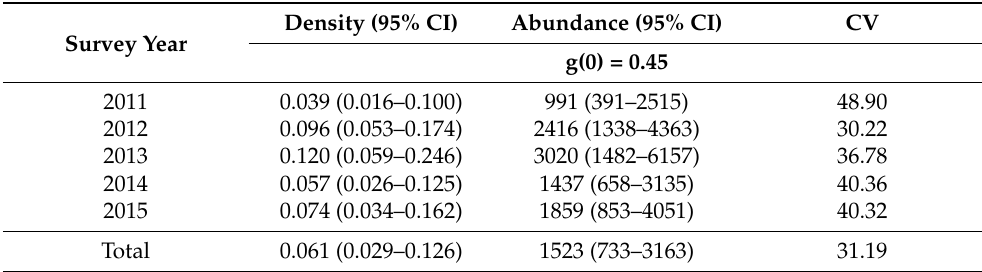
Table 6. Harbour porpoise density (ind/km 2 ) and abundance estimates in Portugal between 2011 and 2015, using g(0) = 0.45 (see Methods: defined for good observation conditions in SCANS II, [11]). CI, confidence interval, CV, coefficient of variation